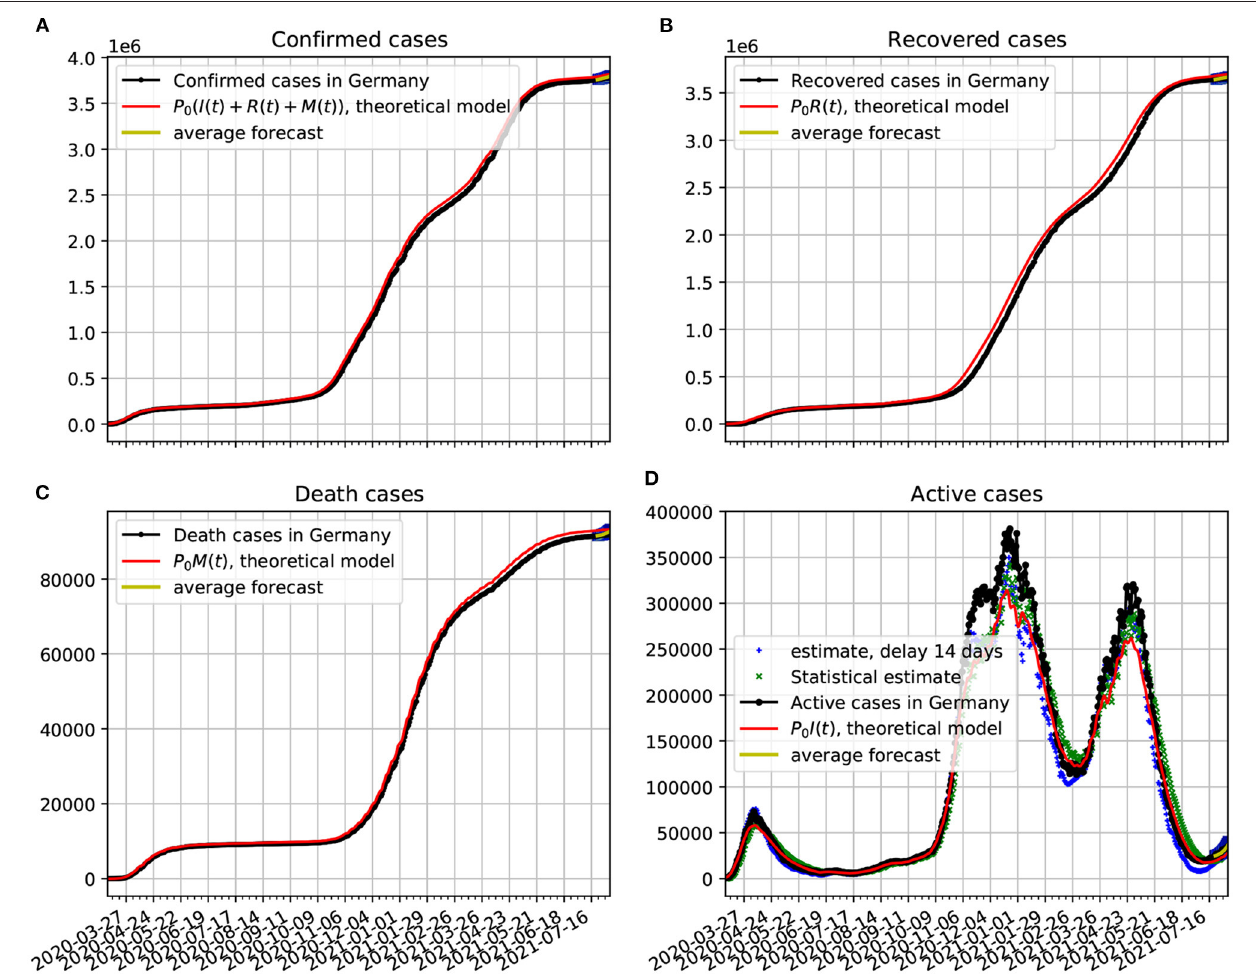
FIGURE 4 | Comparison of epidemiological data from Germany with the best fit based on our theoretical model. Also shown near the end of the time series are the statistical forecasting 95% confidence intervals, as described in Section 3.5. The theoretical fit is obtained with τ Confirmed cases data from Germany compared with the theoretical prediction. (B) Recovered cases data in comparison with the theoretical prediction. (C) Death cases data compared with the theoretical prediction. (D) Active cases compared with delay estimate, statistical estimate, and the predicted theoretical curve. In all cases the functions κ ( t ), λ ( t ), and ρ ( t ) vary in time according to Figure 3